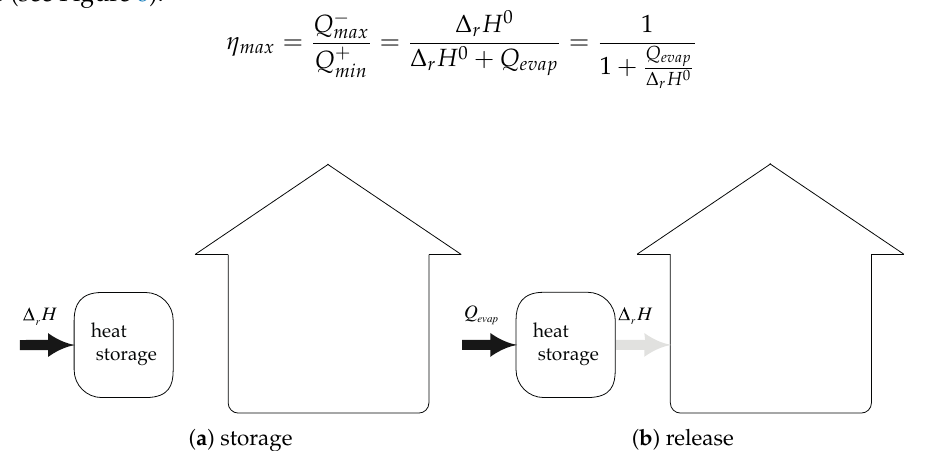
Figure 8. System integration: heat of condensation is not recovered and heat of evaporation is not free: η max = 1 1 + Qevap ∆ rH 0